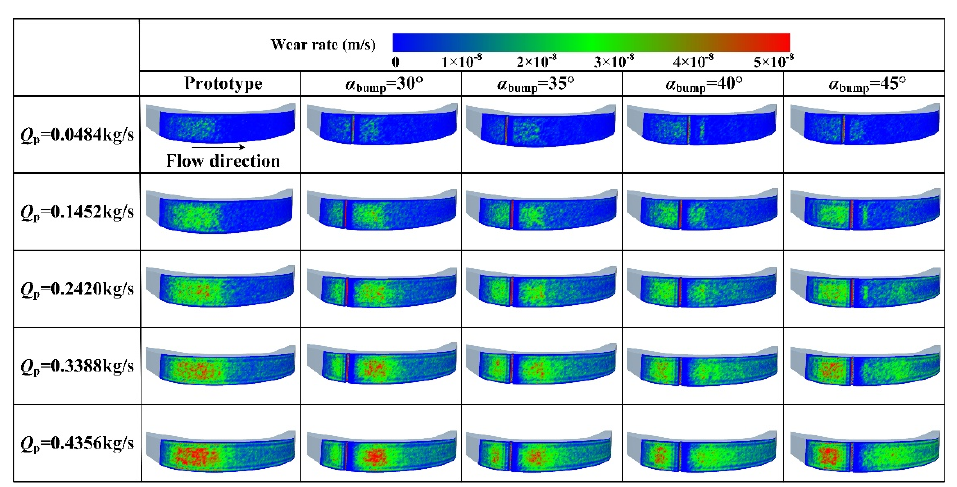
Figure 10. Schematic diagram of the number of particle collisions with the wall.